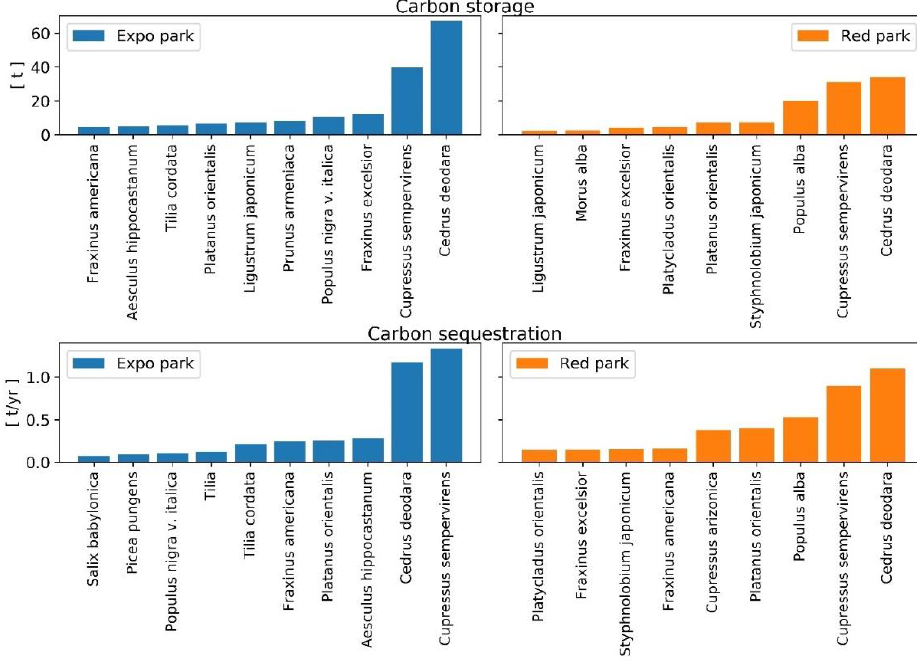
Figure 4. Species that store (carbon storage) and sequester (carbon sequestration) the most carbon in EXPO and RED park.